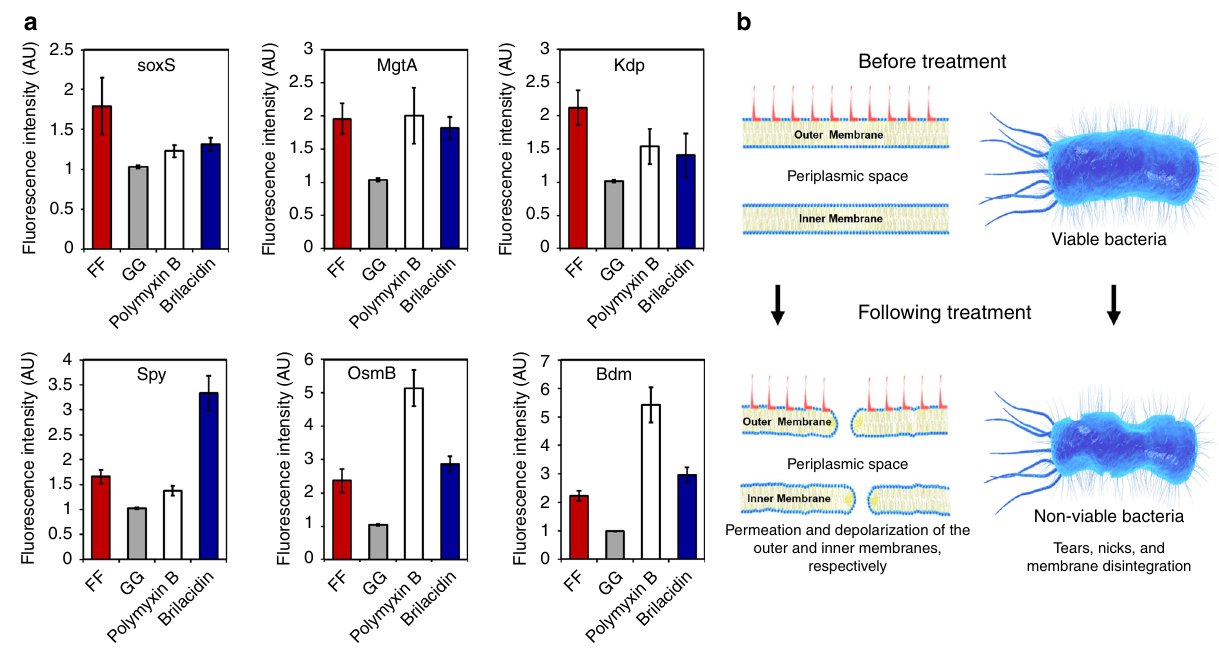
Fig. 3 The effect of diphenylalanine nanostructure treatment on the bacterial stress response and their proposed mechanism of action. a Treatment with diphenylalanine nanostructures causes upregulation of cellular stress-related genes. E. coli bacteria were transformed with plasmids containing each of the six evaluated genes fused to mCherry and the level of fl uorescent signal of mCherry, which correlates to the level of expression of the corresponding gene, was measured following the indicated treatments. b Model of the proposed mechanism of action of the diphenylalanine nanostructures on Gram-negative bacteria. The interaction of the diphenylalanine nanostructures with the bacterial membrane causes outer membrane permeation and inner membrane depolarization, resulting in severe changes to membrane morphology, such as the appearance of nicks and tears, leading to bacterial growth inhibition